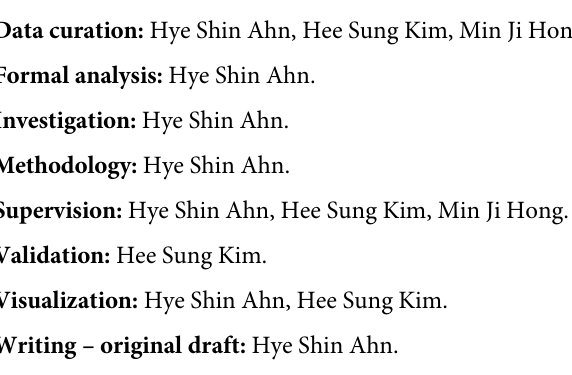
Fig 3. Images of a representative case of follicular adenoma. A 66-year-old woman was diagnosed with widely invasive follicular carcinoma. (a) An US image showing a 2.9 cm-sized heterogeneous ill-defined solid hypoechoic nodule with internal macrocalcification. (b) US-guided FNA is performed with a 21-gauge syringe, and the nodule appears to be a follicular lesion of undetermined significance. (c) The surgical specimen shows microfollicular proliferation with thick fibrous capsule with large pericapsular calcification corresponding to US image shown in Fig 3A (arrows). × 12.5 original magnification. Hematoxylin and eosin staining is used. US, ultrasonography; FNA, fine- needle